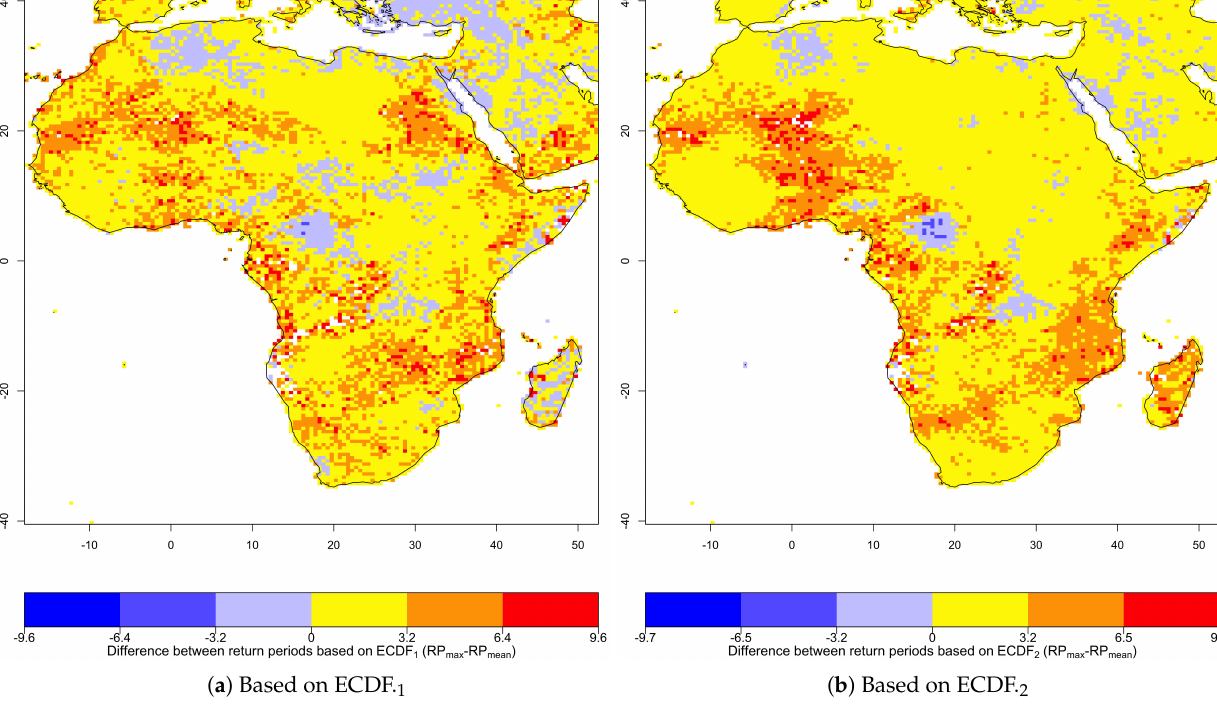
ˆ RP means ) based −